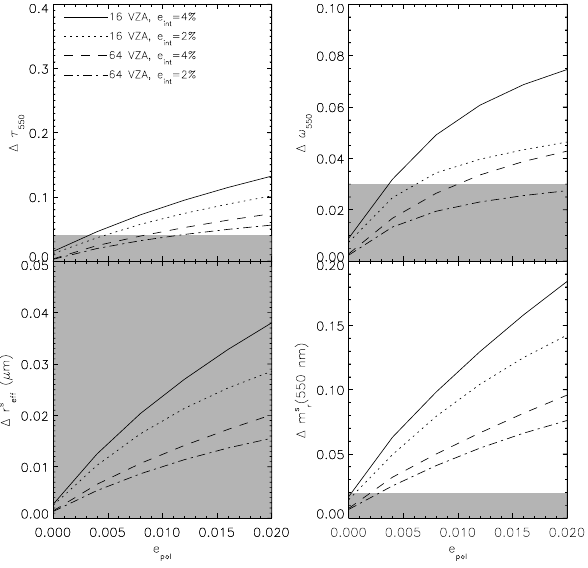
Fig. 4. Retrieval error on the aerosol optical thickness (upper left panel), single scattering albedo (upper right panel), fine mode ef- fective radius (lower left panel), and fine mode real refractive index (lower right panel), as a function of polarimetric accuracy, for a situation with a biomass burning aerosol layer with AOT=0.5 situ- ated between 0–2km, below a partially clouded scene (cloud frac- tion=0.1) with a cloud layer between 2–3km. Simulations have been performed for a relative azimuth angle 1ϕ = 0 ◦ . Multi-angle photo-polarimetric measuremenst with respectively 16 and 64 view- ing angles have been considered. Radiometric accuracies have been considered of respectively 2% and 4%. Errors are assumed to be uncorrelated.